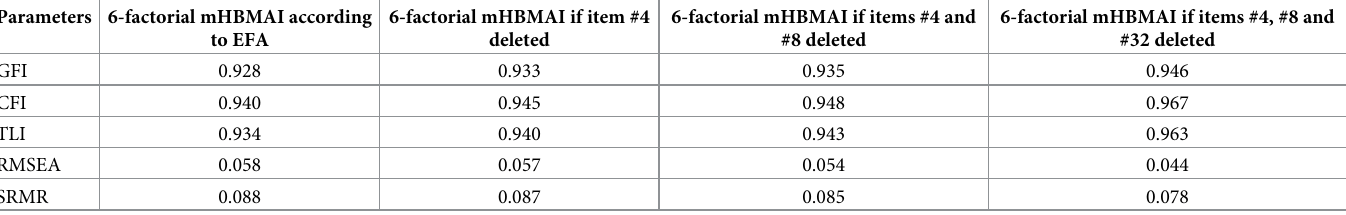
EFA-exploratory factor analysis; GFI-goodness of fit index,CFI-comparative fit index, TLI-Tucker-Lewis index, RMSEA- root mean square error of